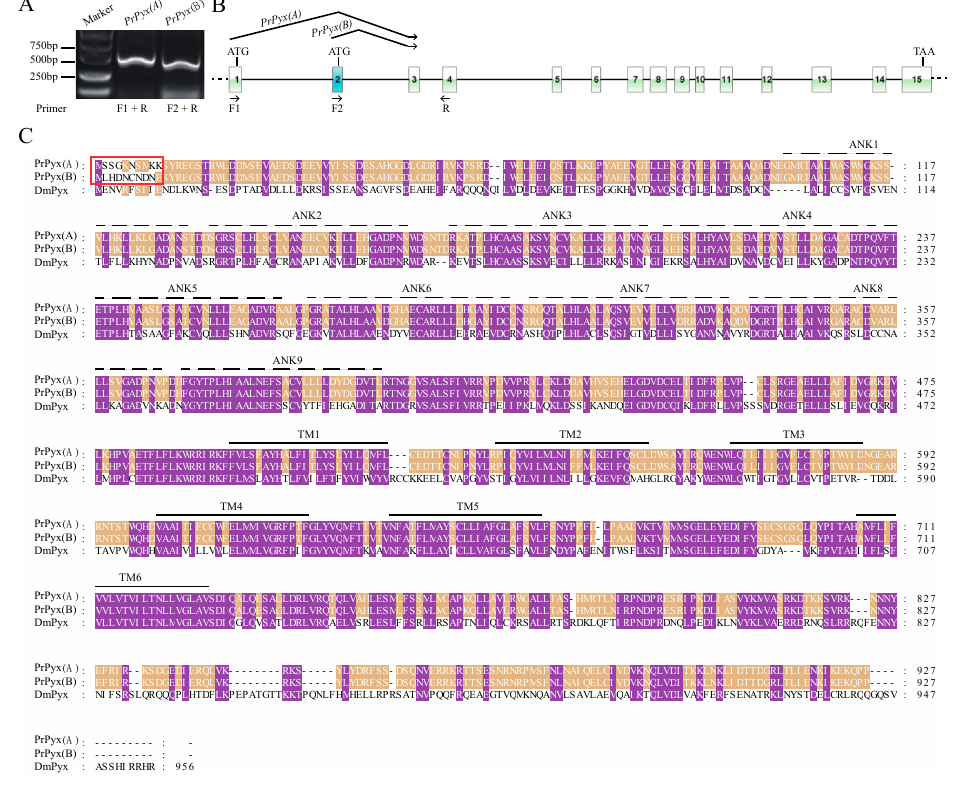
Figure 2. Detection and amino acid sequence alignment of the two PrPyx splice forms. ( A ) Two molecular isoforms of PrPyx mRNAs identified by PCR. ( B ) Two-dimensional gene structure map of PrPyx . The boxes represented the exons of PrPyx , the black solid lines connecting the boxes represented the introns, and the black dotted lines on both sides represent other genome sequences. ( C ) Multiple sequence alignment deduced for PrPyx(A), PrPyx(B) and DmPyx. The red box indicates the different amino acid residues of the two isoforms. Ankyrin repeats were indicated with dotted lines and marked as ANK1–9. Transmembrane regions were indicated with solid lines and marked as TM1–6. The protein sequences used for multiple sequence alignment were in the attached fasta file.